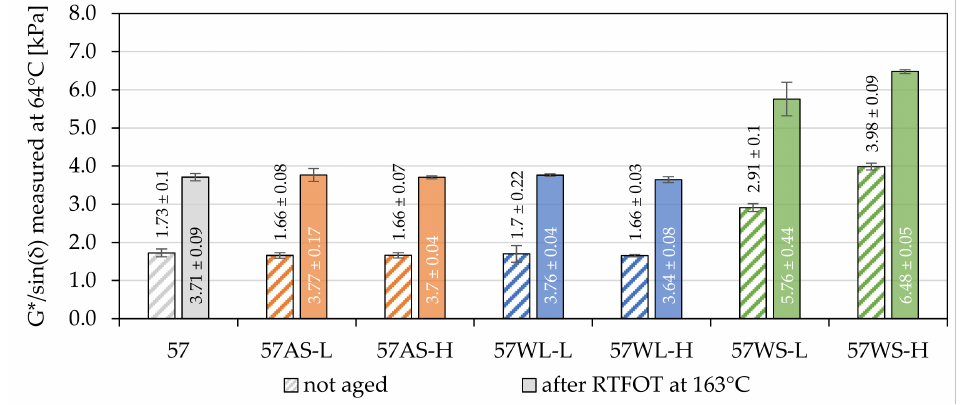
Figure 6. High-temperature stiffness of the investigated asphalt binders based on the 50/70 penetration